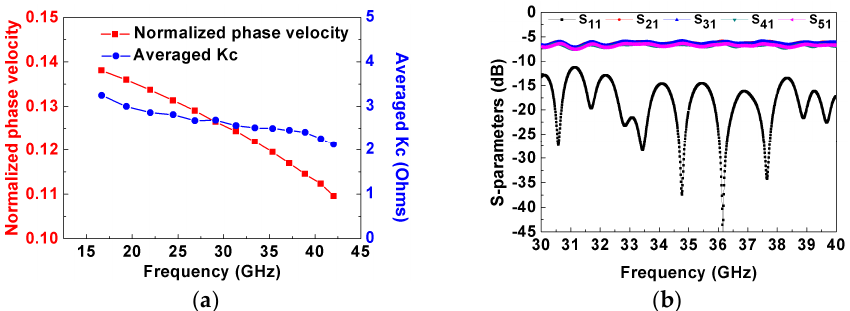
Figure 4. Plot of the dispersion curve (red) and the averaged interaction impedances (blue) versus frequency ( a ); S-parameters of the transmission model ( b ).